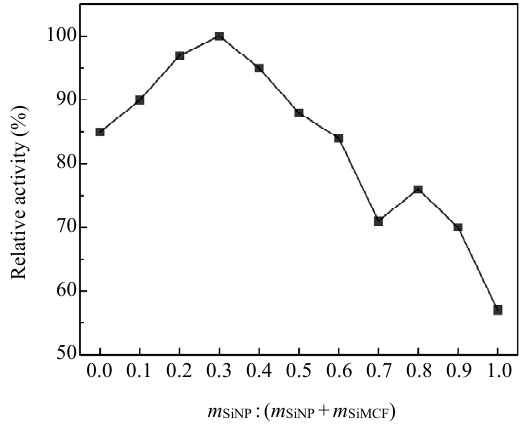
Fig. 1 Activity of GOD @ (SiMCFs + SiNPs).